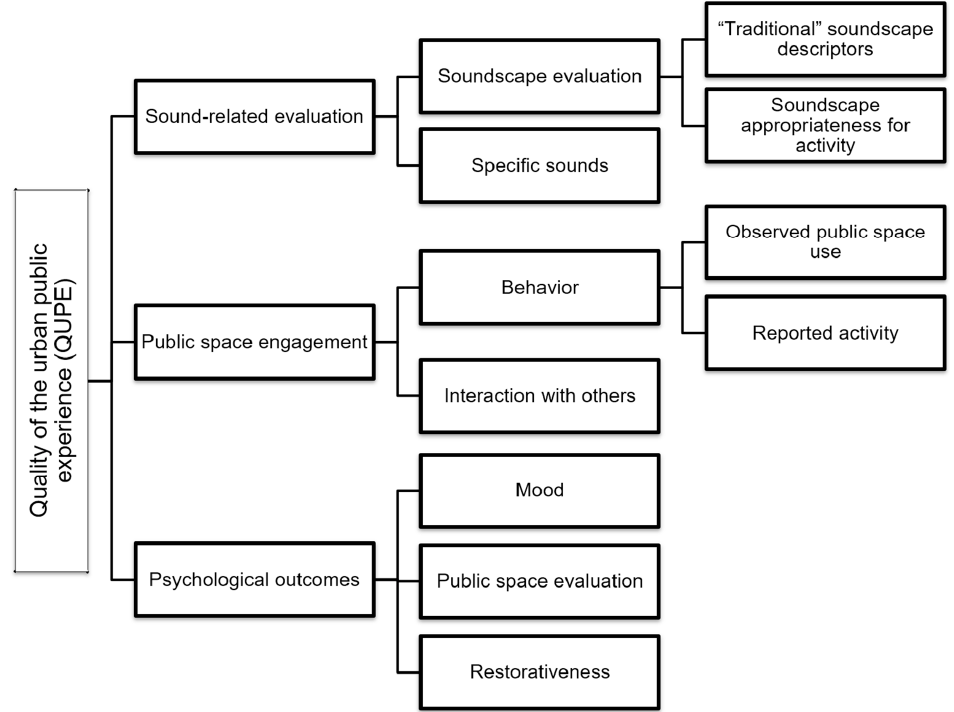
Figure 1. The QUPE (quality of the urban public experience) model. Three axes are elaborated and inform the structure of the present study.